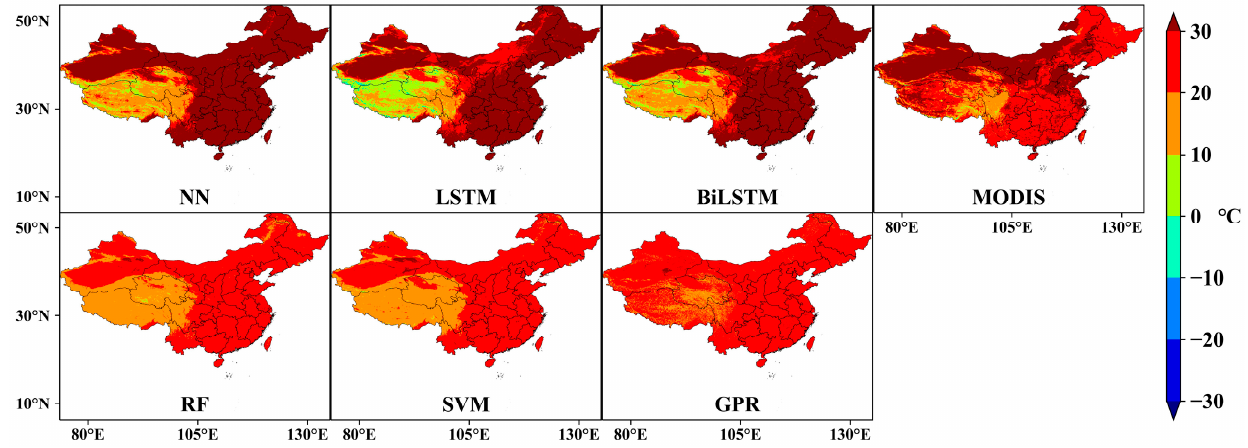
Figure 10. The NLSAT estimation results for the summer of 2015.